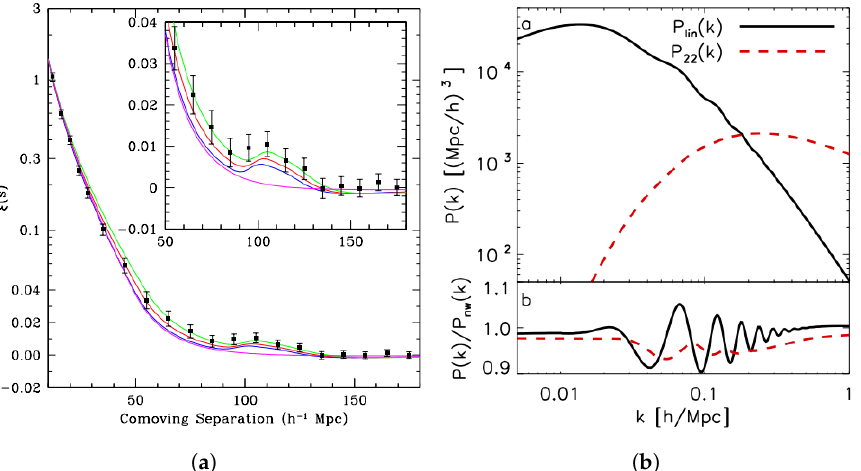
Figure 8. ( a ) The large-scale redshift-space correlation function of the SDSS LRG sample. Adapted from: [27]. ( b ) Damped oscillations in the large-scale structure power spectrum. Adapted from: